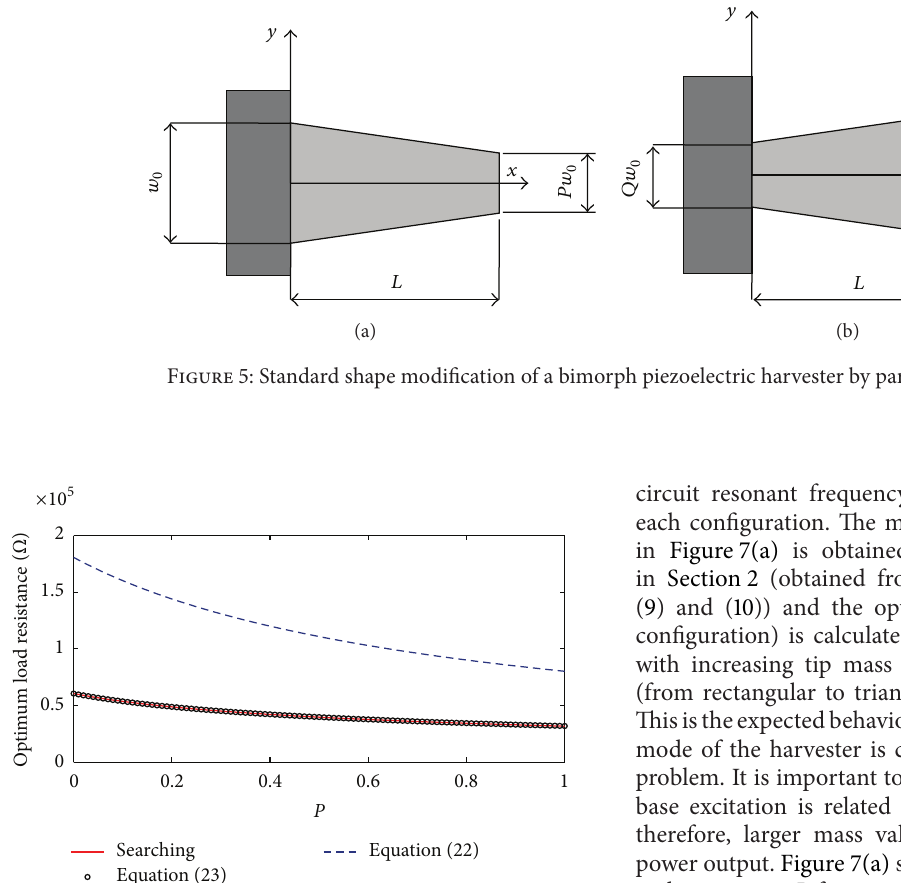
Figure 6: Variation of optimum load resistance with parameter P